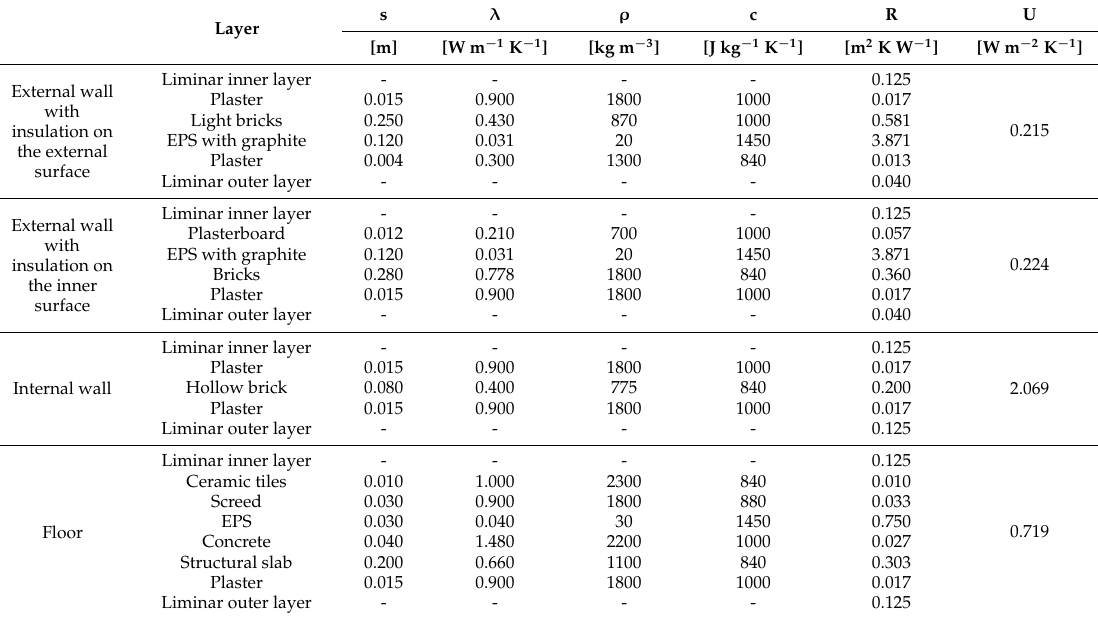
Table A3. Stratigraphy and thermal properties of the structures of the well-insulated masonry buildings (WIE and WII).